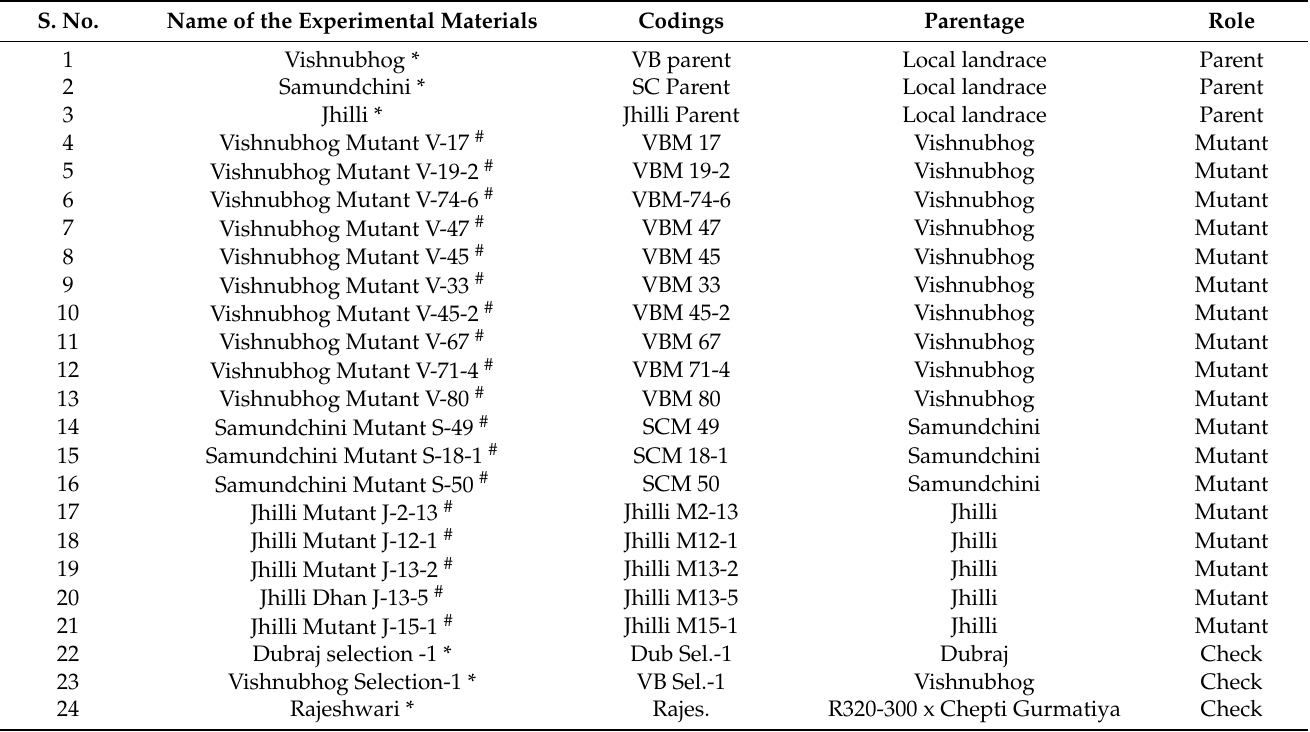
Table 9. List of experimental materials used in the current